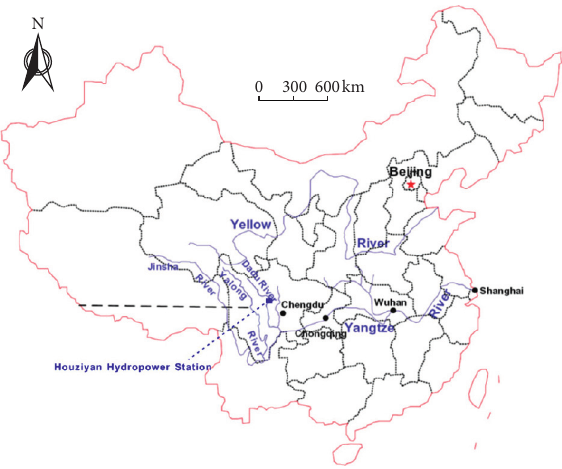
Figure 1: Regional map of Houziyan hydropower station.